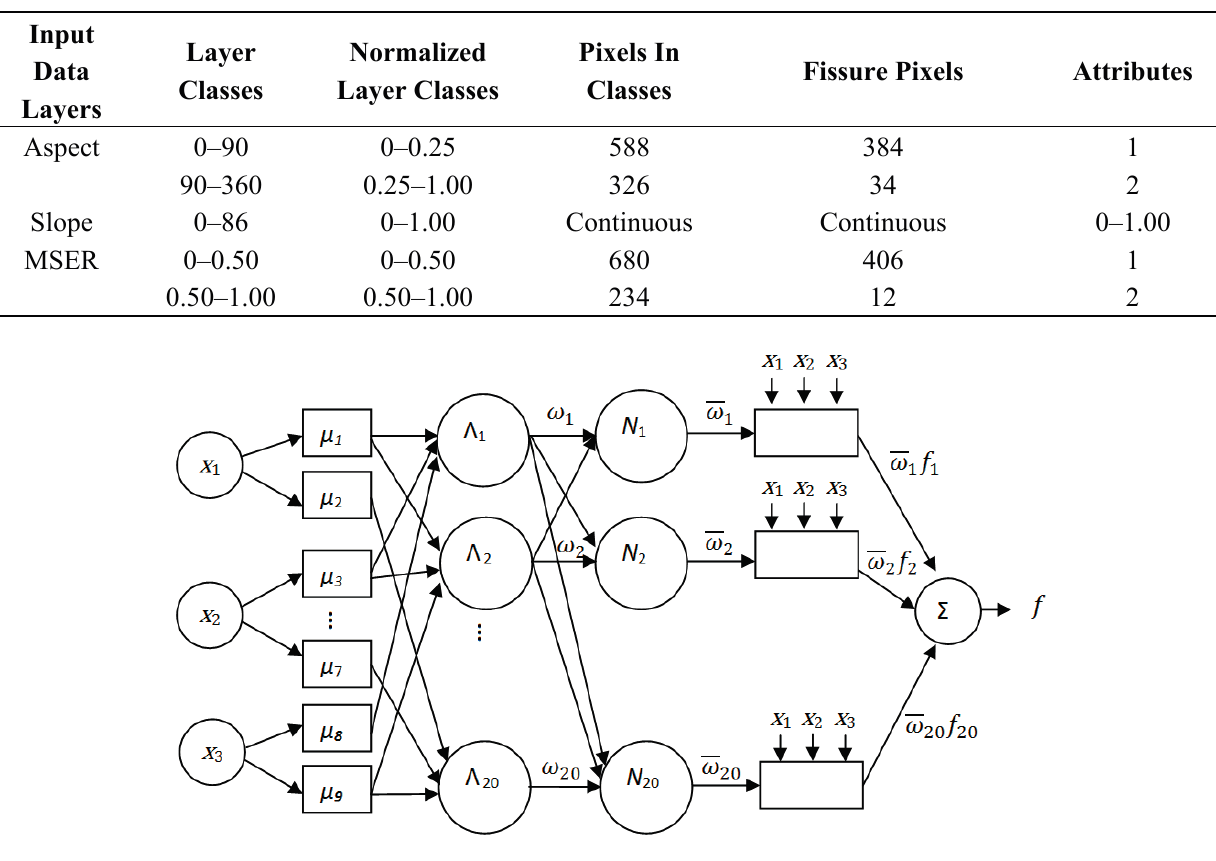
Table 3. The summary of input data layers.